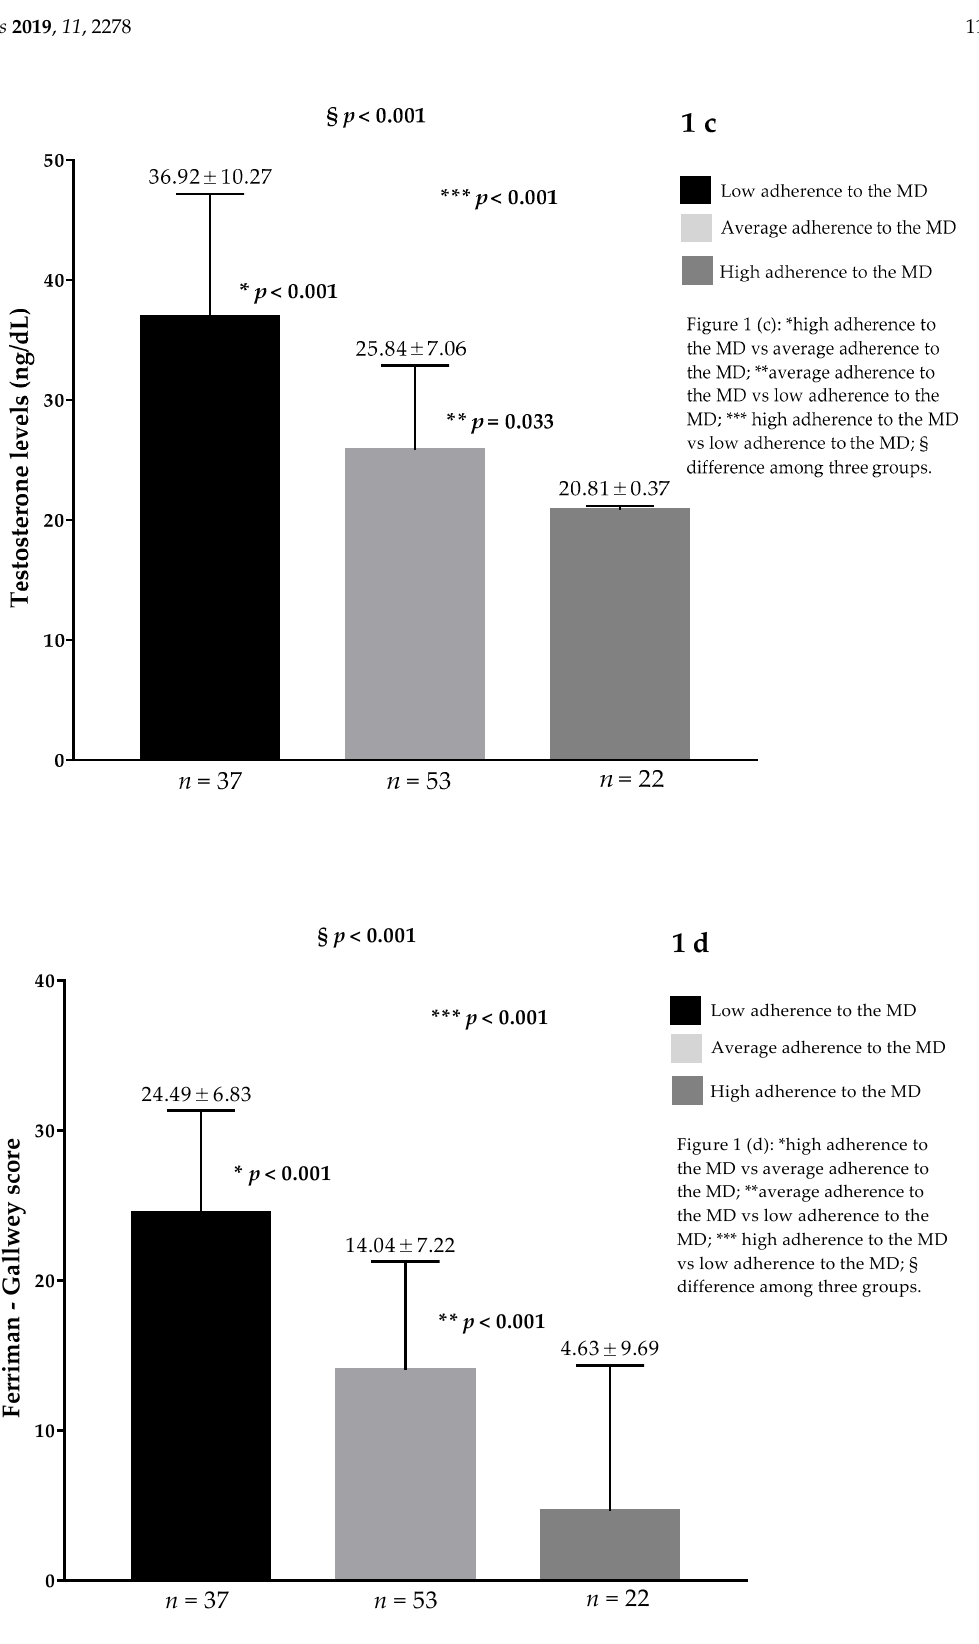
Figure 1. In Figure 1 were reported the di ff erences of CRP levels, HoMA-IR, testosterone levels, and Ferriman-Gallwey score of the PCOS women on the basis of the PREDIMED categories. As showed in Figure 1, the PCOS women with a low adherence to the MD presented higher CRP levels ( a ), HoMA-IR ( b ), testosterone levels ( c ), and Ferriman-Gallwey score ( d ) than average and high adherers to the MD ( p < 0.001, respectively). CRP, C-reactive protein; MD, Mediterranean diet; HoMA-IR, Homeostasis model assessment insulin resistance; PCOS, Polycystic ovary syndrome; PREDIMED, PREvenci ó n con DIetaMEDiterr á